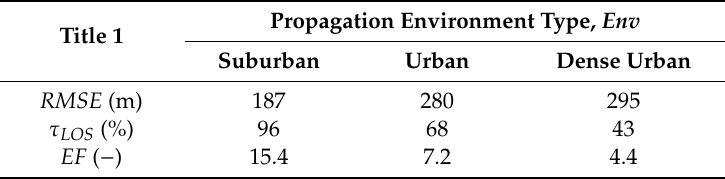
Figure 11. Cumulative distribution function (CDFs) of the location error versus the different types of urbanized areas. Table 1. Effectiveness metrics for the different types of urbanized areas.